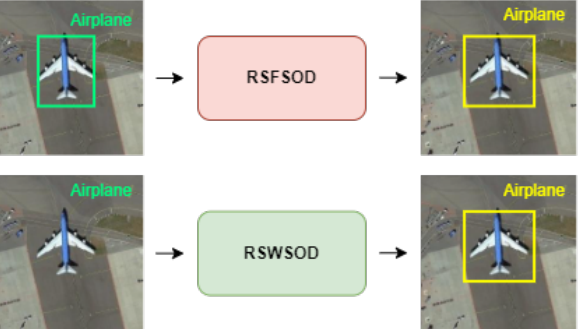
Figure 4. Visual explanation of RSFSOD and RSWSOD. In the top image, the green BB represents the ground-truth location information as given to the fully supervised detector. Such information is not present during the training of a weakly supervised detector, as shown in the bottom